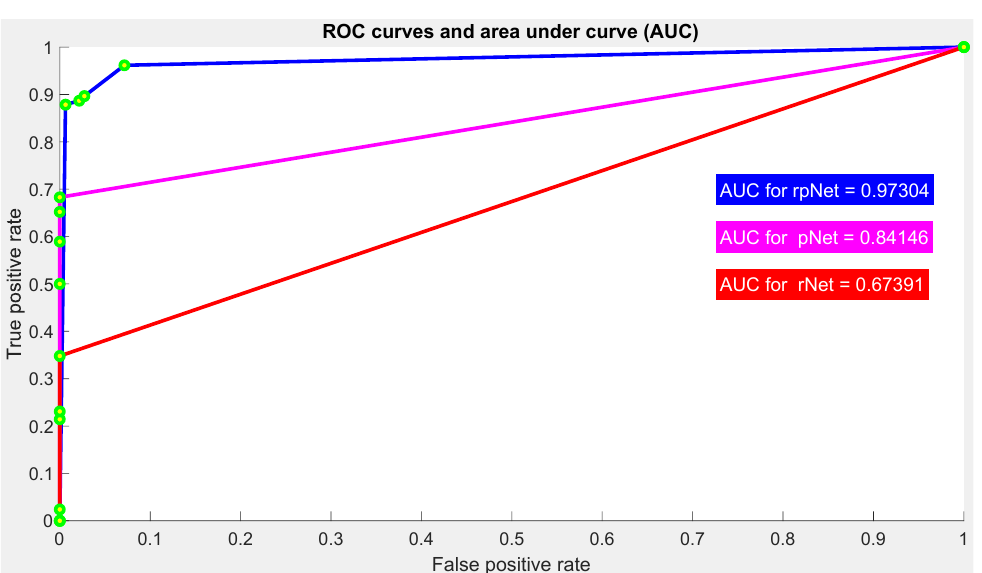
Figure 12. Performance comparison of rNet, pNet, and rpNet deeming data in Table